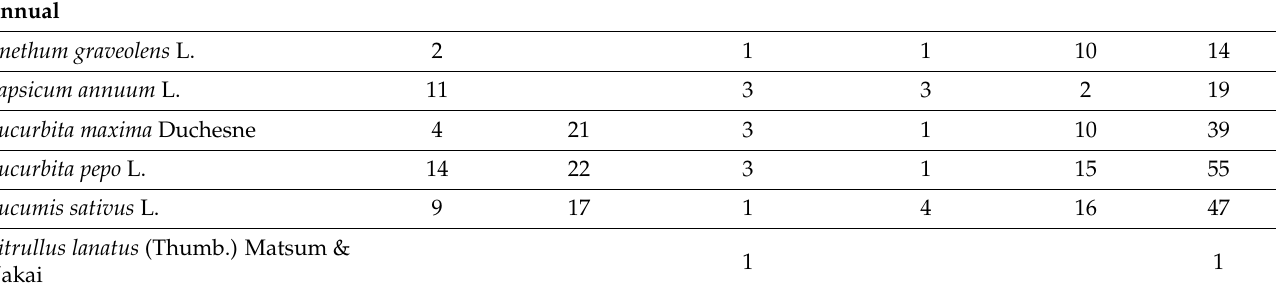
Table 1. Accessions collected during three expeditions to Lithuania in 2011, 2012, and 2013. Number of Accessions Collected in Each Ethnographic Region Species Aukštaitija Dz¯ukija Mažoji Lietuva Suvalkija Žemaitija Fruit trees and bushes Malus × domestica